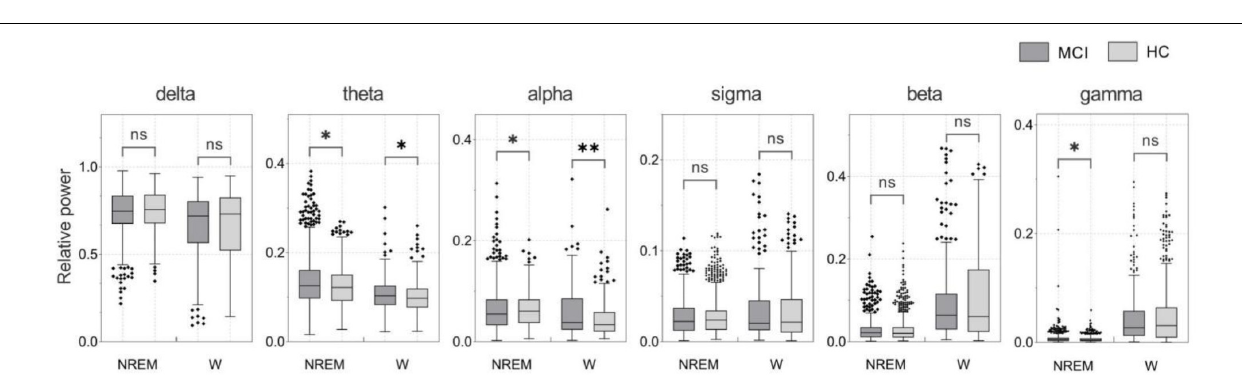
FIGURE 4 | Relative power of NREM sleep and awake EEG in MCI and HC subjects ( ∗ p < 0.05; ∗∗ p <